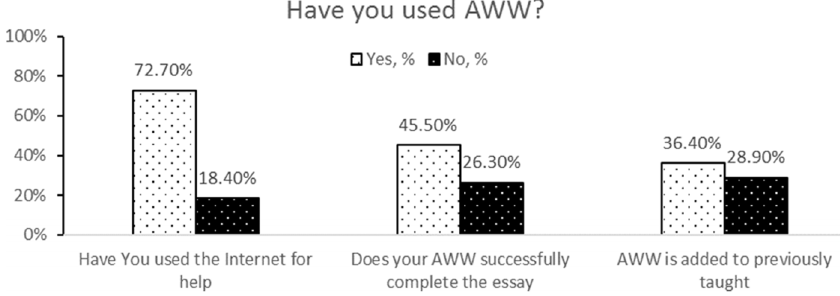
Fig. 6 Comparison of answers to questions regarding who used AWW and who did not